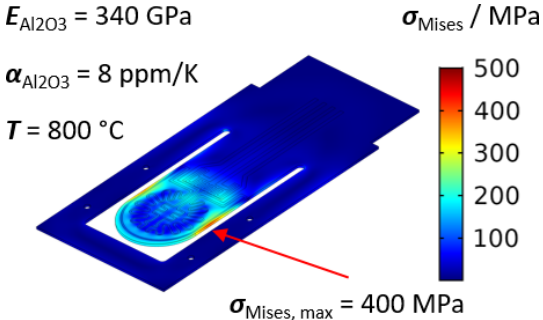
Figure 4. FEM simulation of the thermally induced mechanical stress at 800 ◦